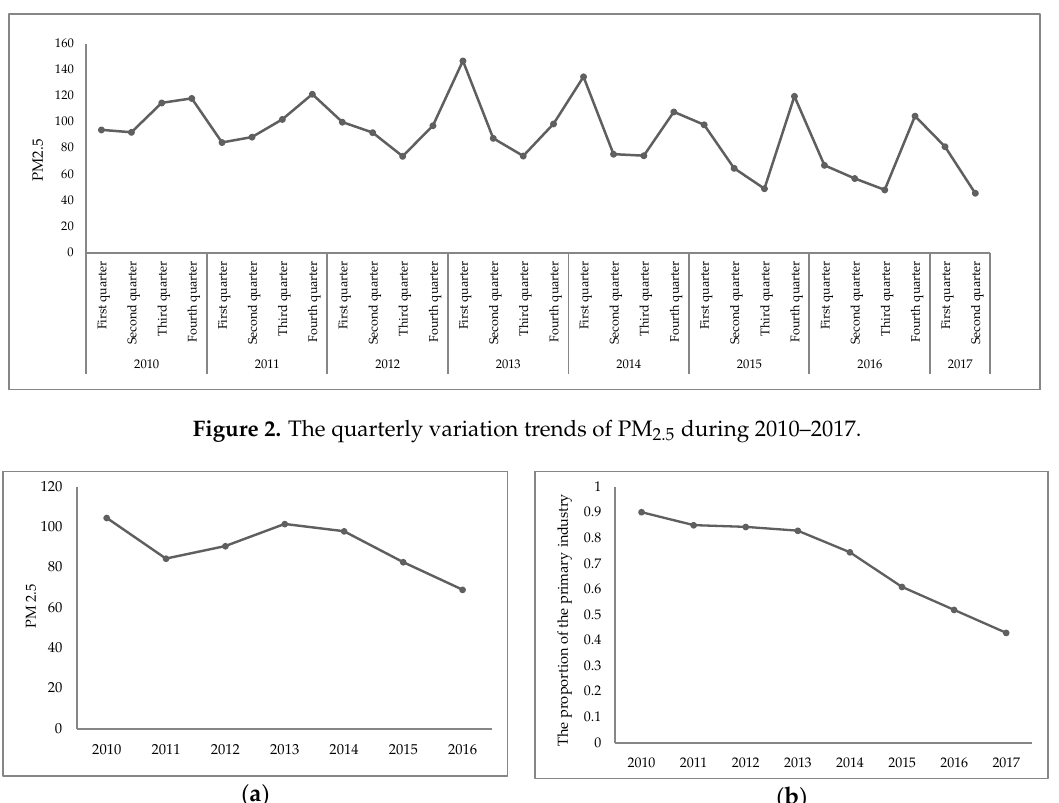
Figure 2. The quarterly variation trends of PM 2.5 during 2010 – 2017.